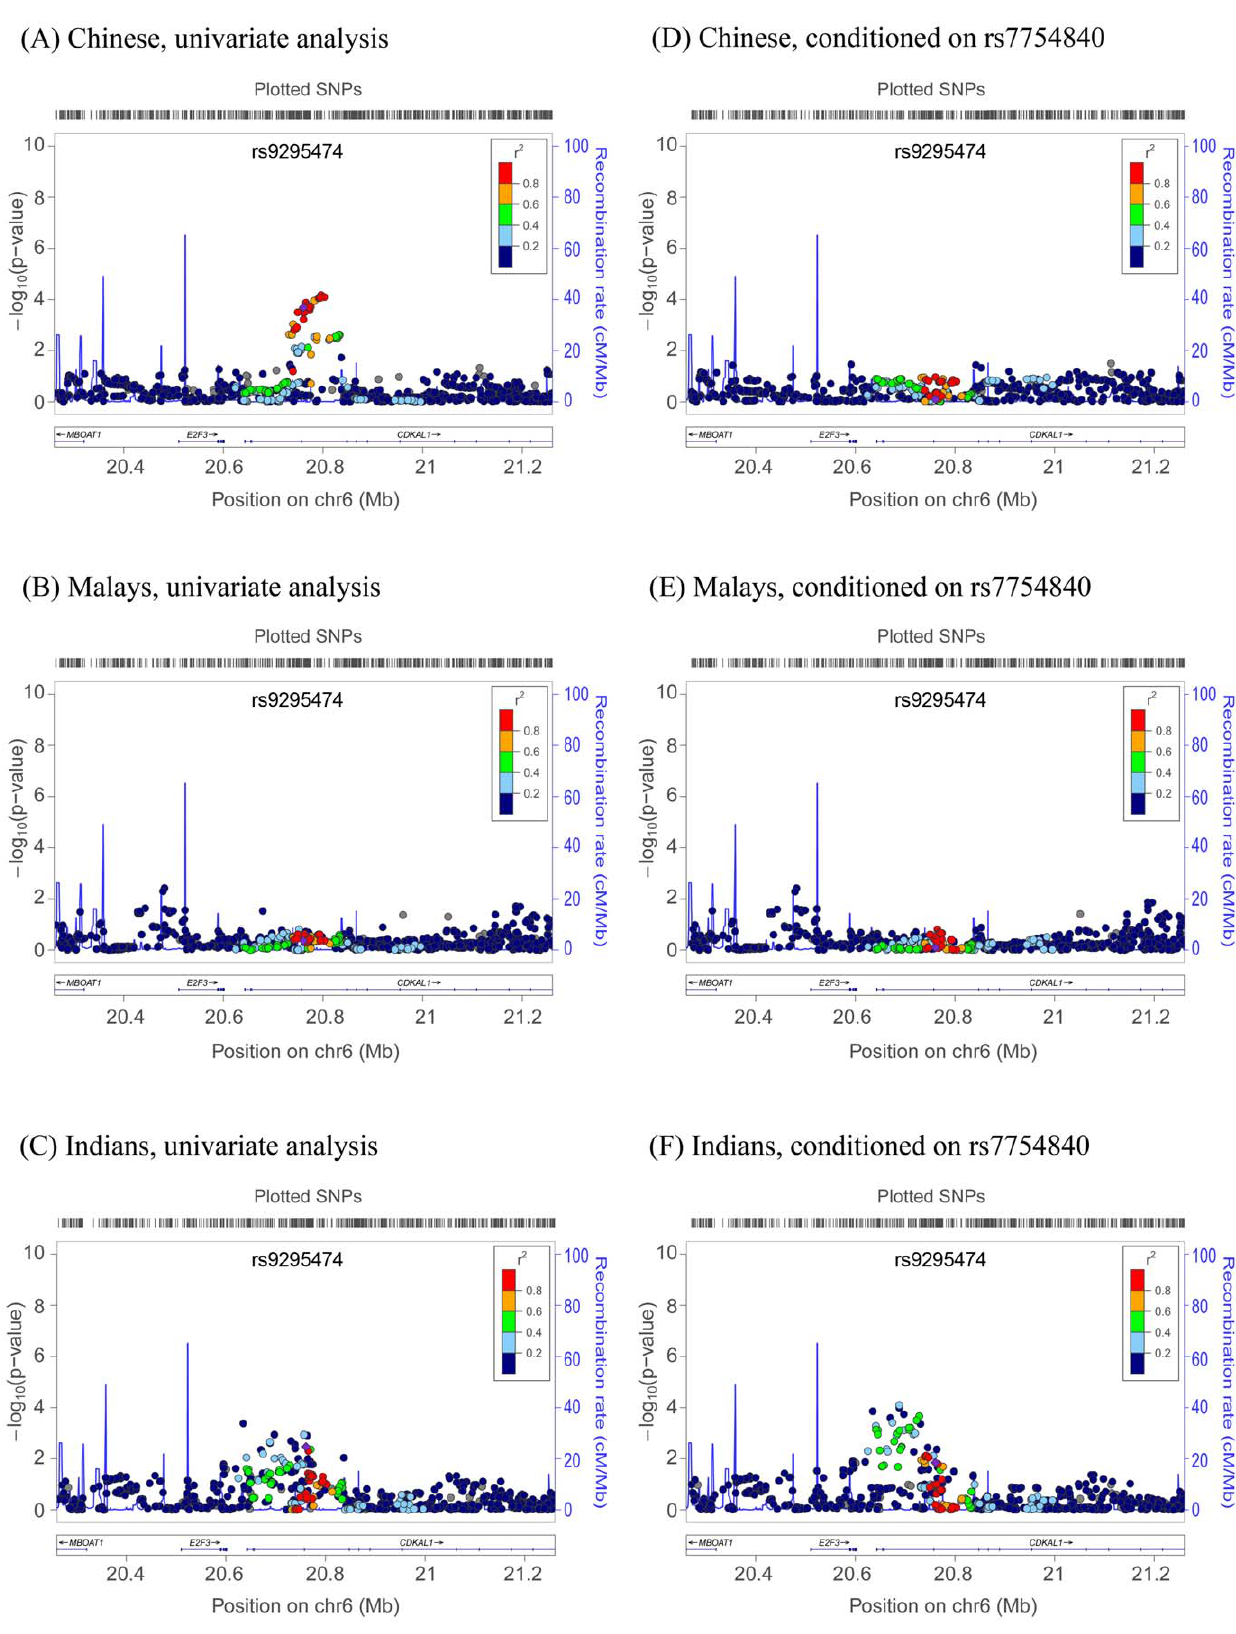
Figure 2. Regional association plots of the index SNP in CDKAL1 . For each ethnic group, the univariate analysis regional plot, A) Chinese B) Malays C) Indians, is shown together with analysis conditioned on established index SNP rs7754840, D) Chinese E) Malays F) Indians, in populations of